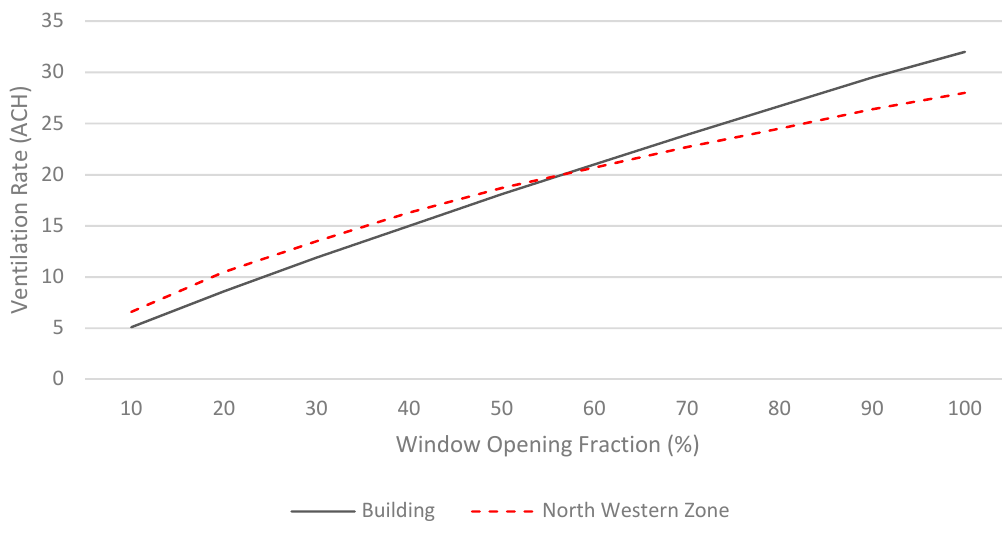
Figure 5. Average wind speed and wind direction in Jeddah, KSA [60].